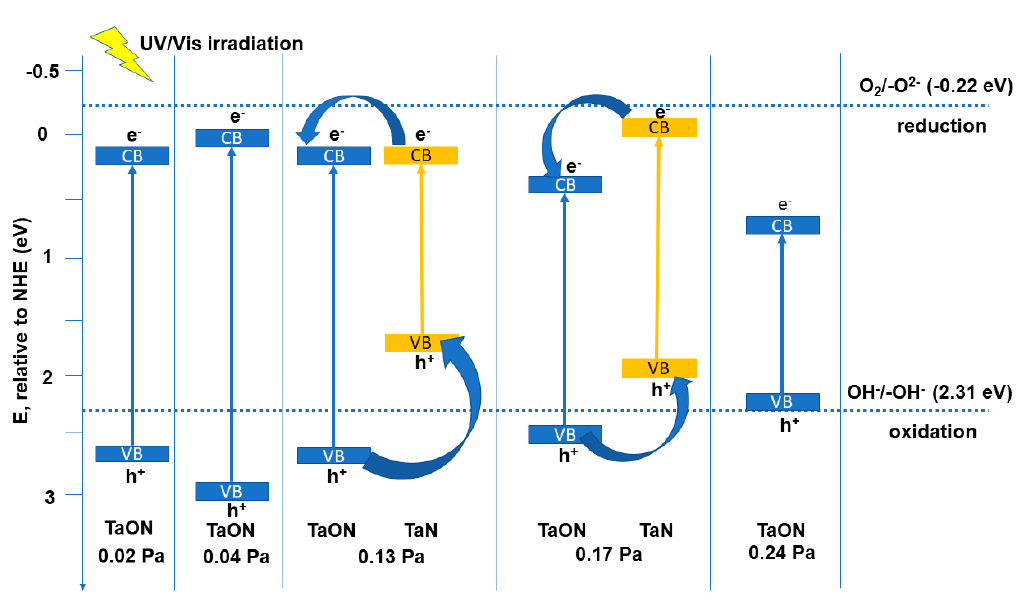
Figure 10. Band edge positions for the thin films.